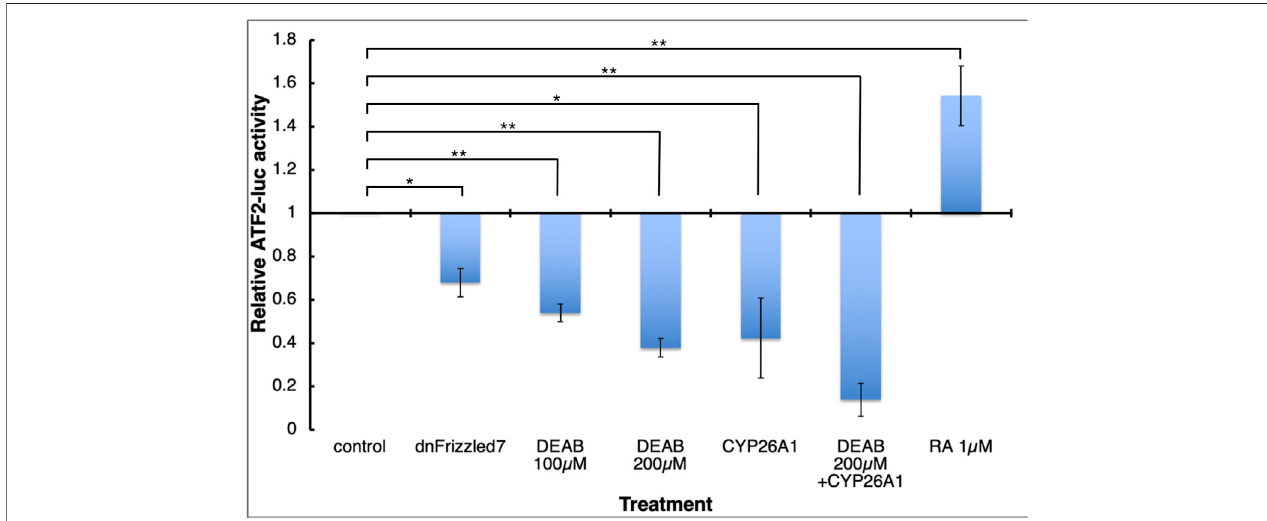
FIGURE8| RAsignaling isnecessaryfornormalWnt/PCP activity. Embryoswereinjected withtheATF2-basednon-canonicalWntsignaling reporterplasmidand subjectedtoDEABorRAtreatments,orco-injectedwithmRNAencodingdominant-negativeFrizzled7orCYP26A1.Duringlategastrula(st.12)embryoswerecollected and analyzed and the effect on the reporter activity (luciferase) was determined. *, p < 0.05; **, p < 0.01.